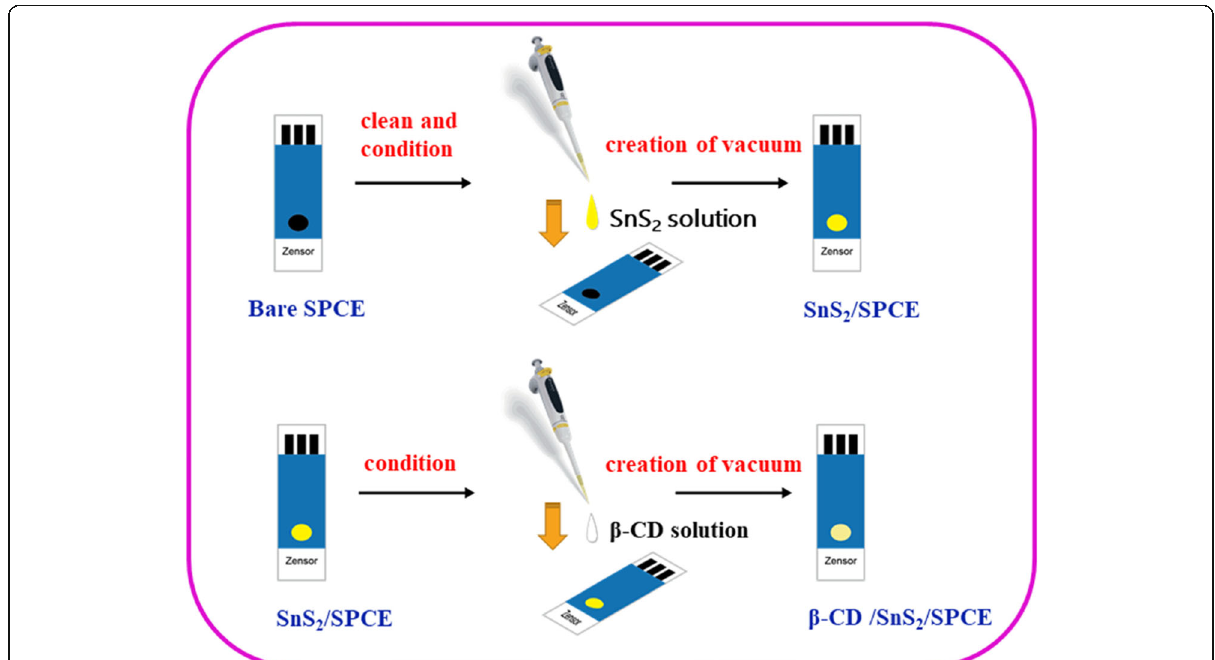
Fig. 2 The preparation and fabrication of β -CD/SnS 2